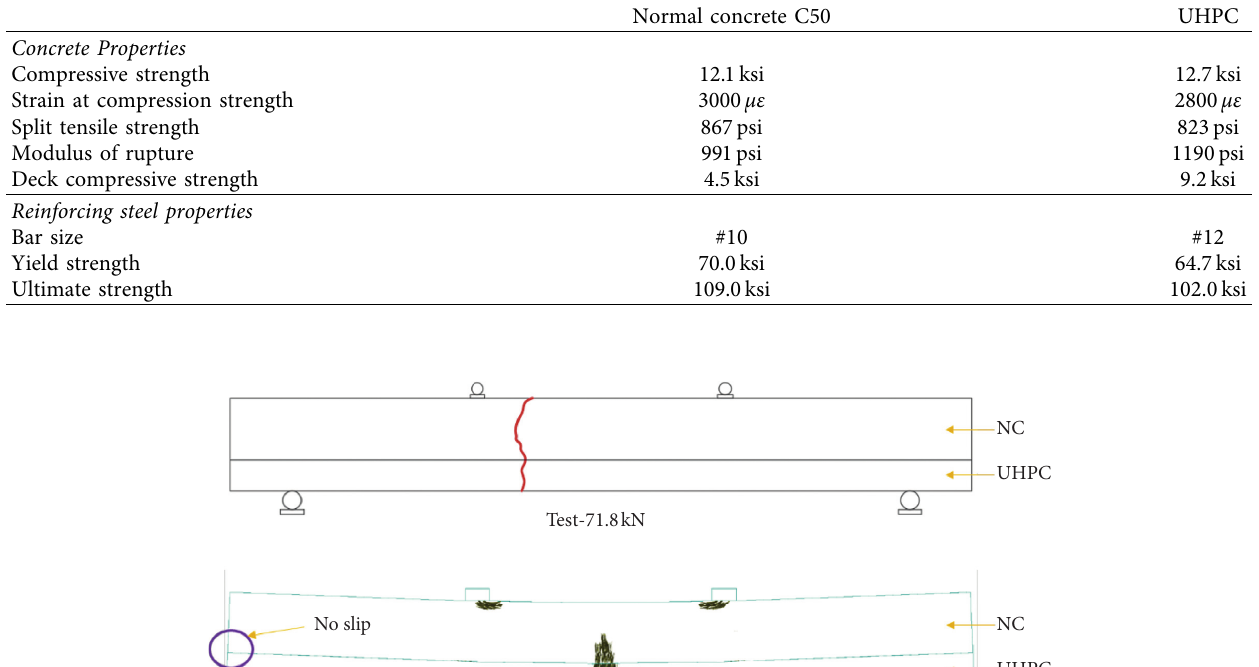
Table 7: Summary of concrete strength